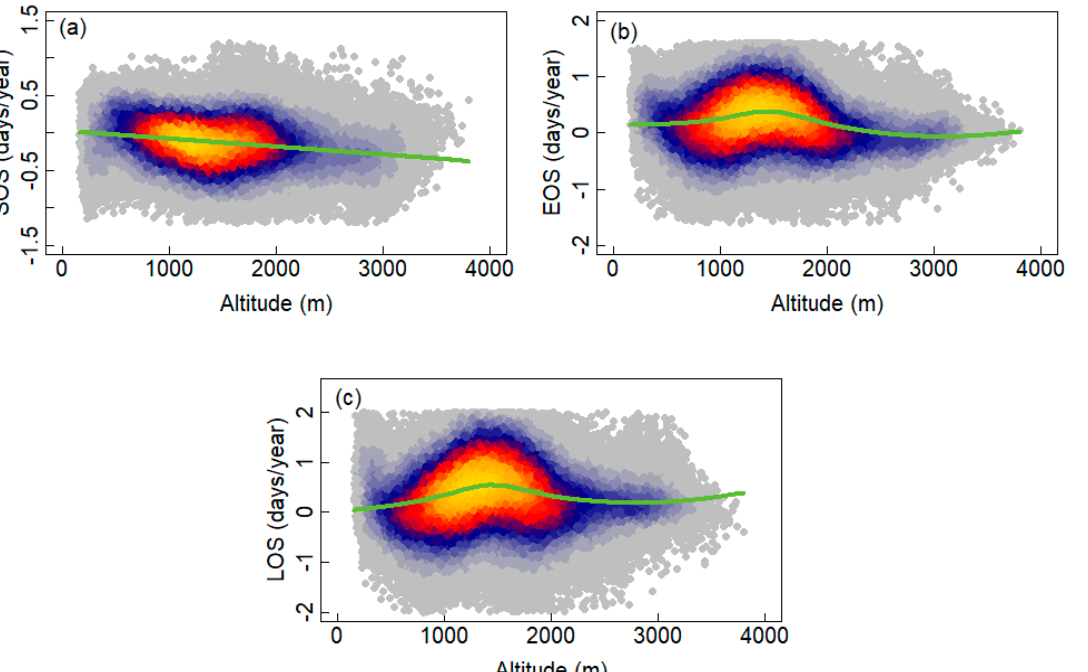
Figure 6. Interannual changes in SOS ( a ), EOS ( b ), and LOS ( c ) across altitudinal gradients from 2001 to 2017. Warm color represents high point density.